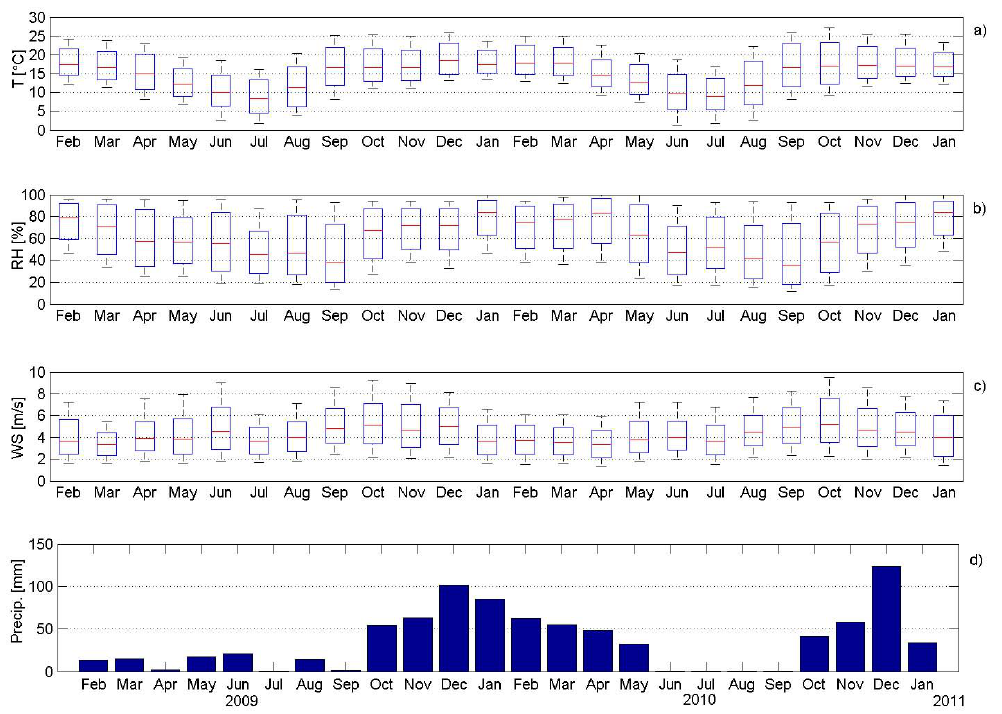
Fig. 5. Meteorological characteristics of the Elandsfontein observation site on the South African Highveld: (a) temperature, (b) relative humidity, (c) wind speed, and (d) monthly accumulated precipitation for the period 11 February 2009–31 January 2011. The red lines represent the 50% percentile, the blue boxes the 25 and 75% percentiles and the black whiskers the 5 and 95% percentiles, except in (d)